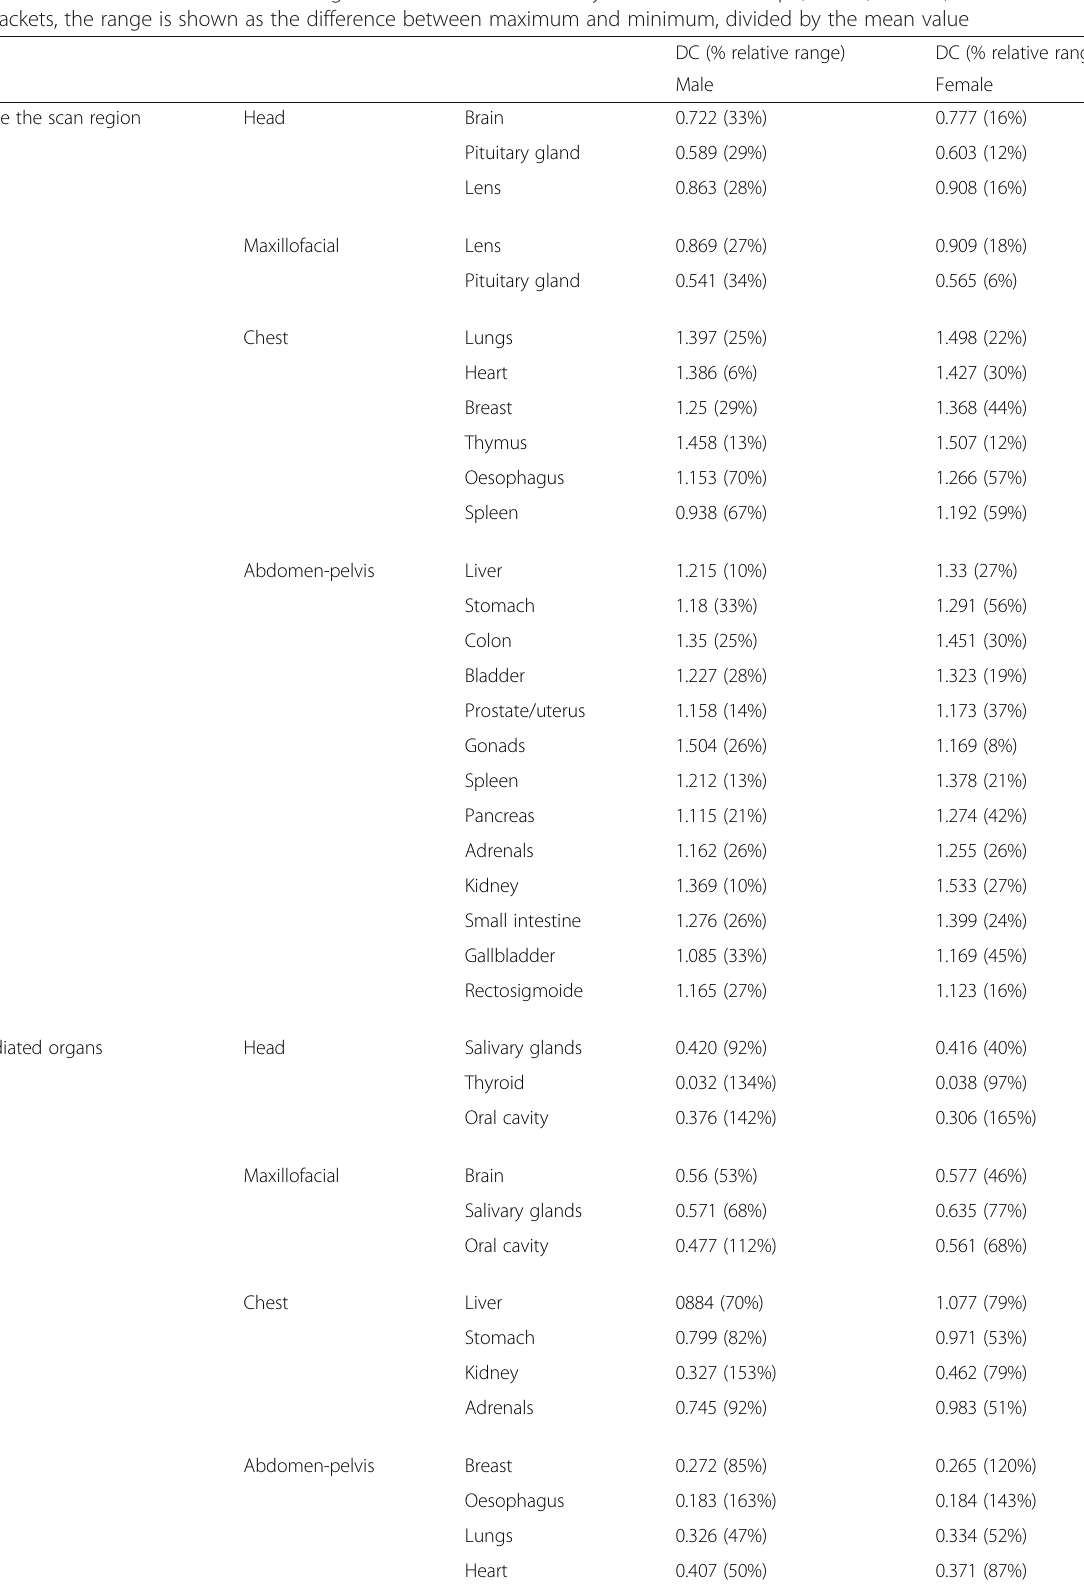
DC (% relative range) Male Female